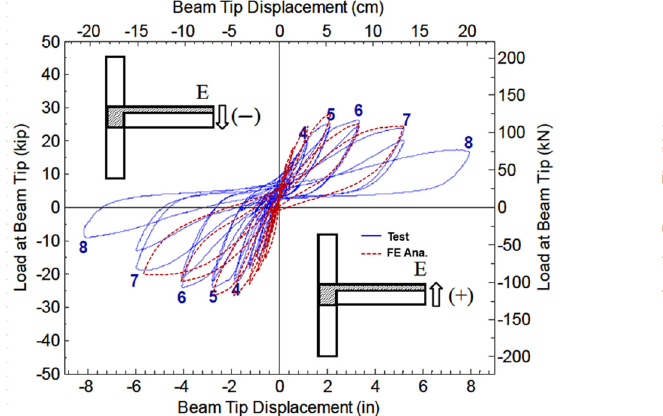
Figure 8. Stress–strain curve for concrete used for FE analysis.